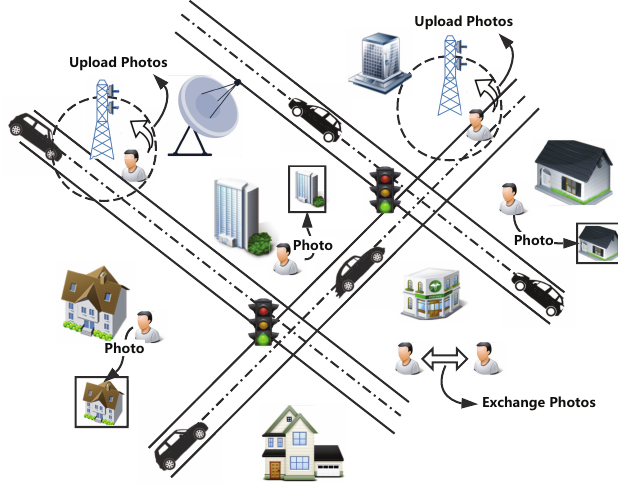
Figure 1. A running example of photo